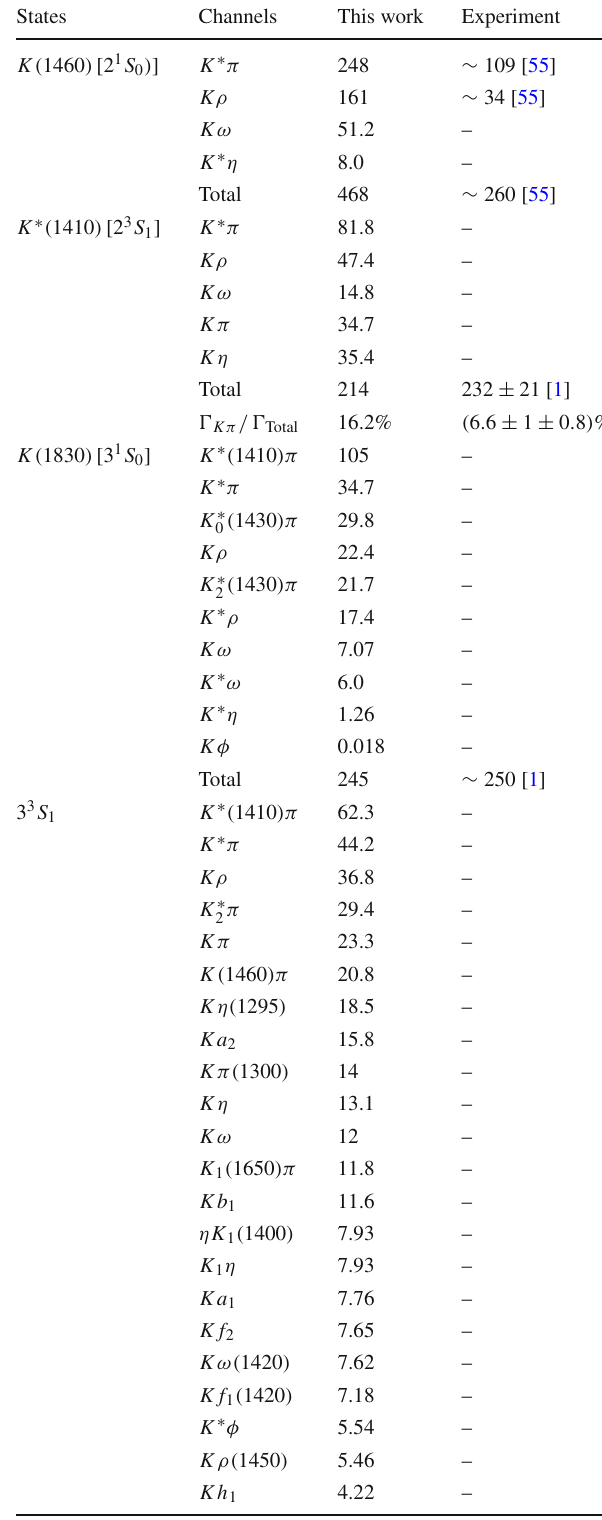
Table 5 The strong decay widths of the 2 S and 3 S states. The unit of the width is MeV States Channels This